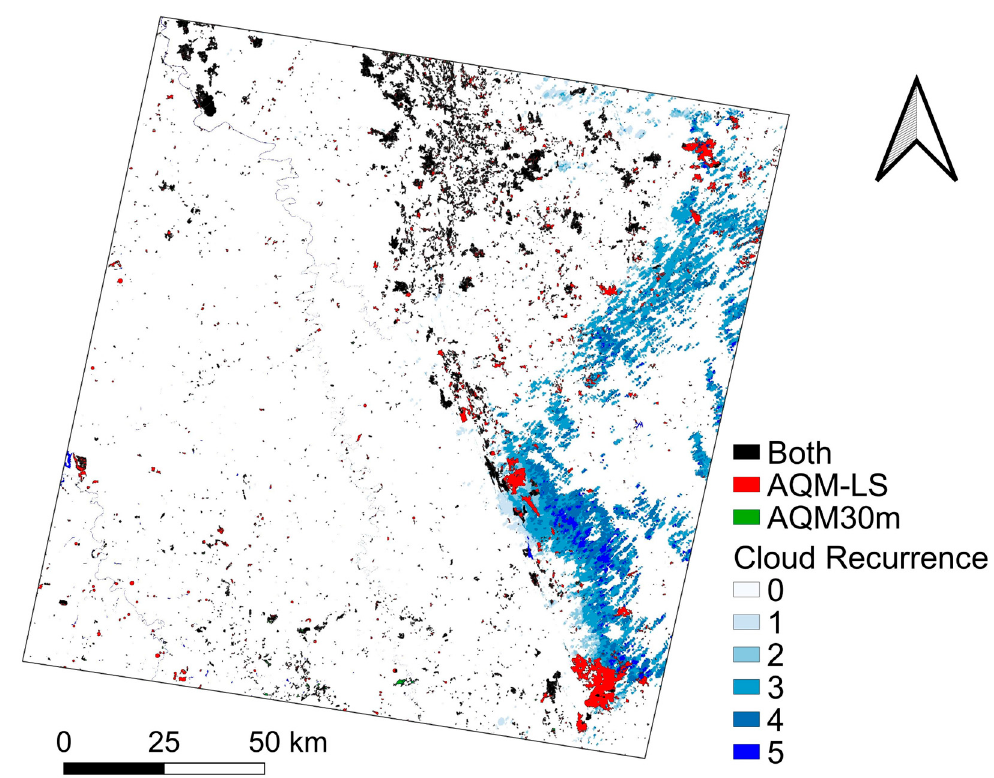
Figure 3. Fire scars as detected by AQM-LS (red) (1020 km 2 ), AQM30m (green) (460 km 2 ) and by both products (black) (413 km 2 ) for Landsat scene 218/073, highlighting cloud recurrence (number of times that a pixel is covered by clouds over study areas, in blue, in # scenes in the post-fire composite) during the period depicted in Table 1.